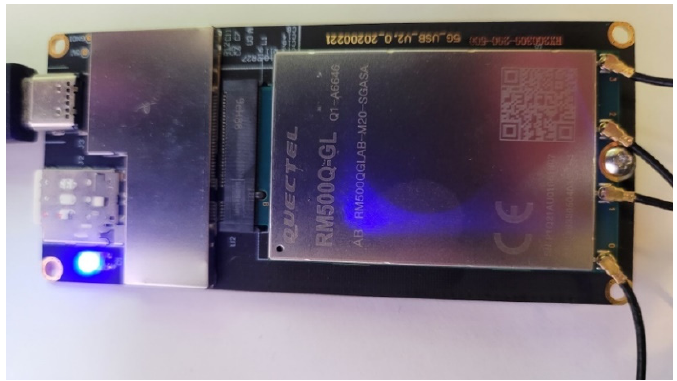
Figure 21. Actual usage of RM500Q-GL.